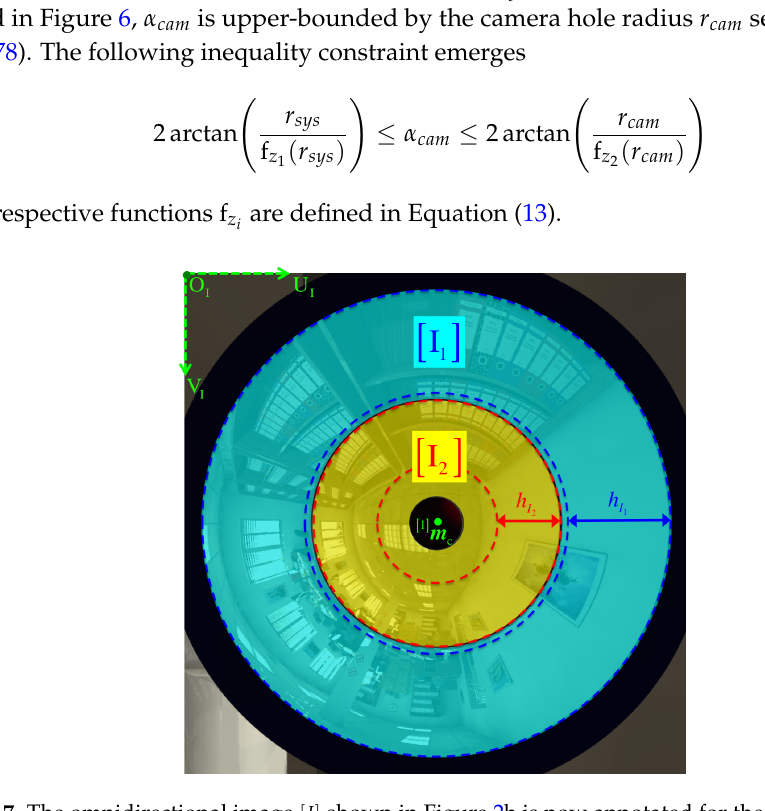
and h I of the 2 1